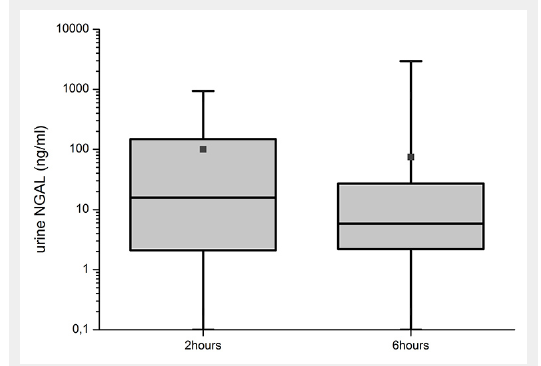
Serum Cystatin C